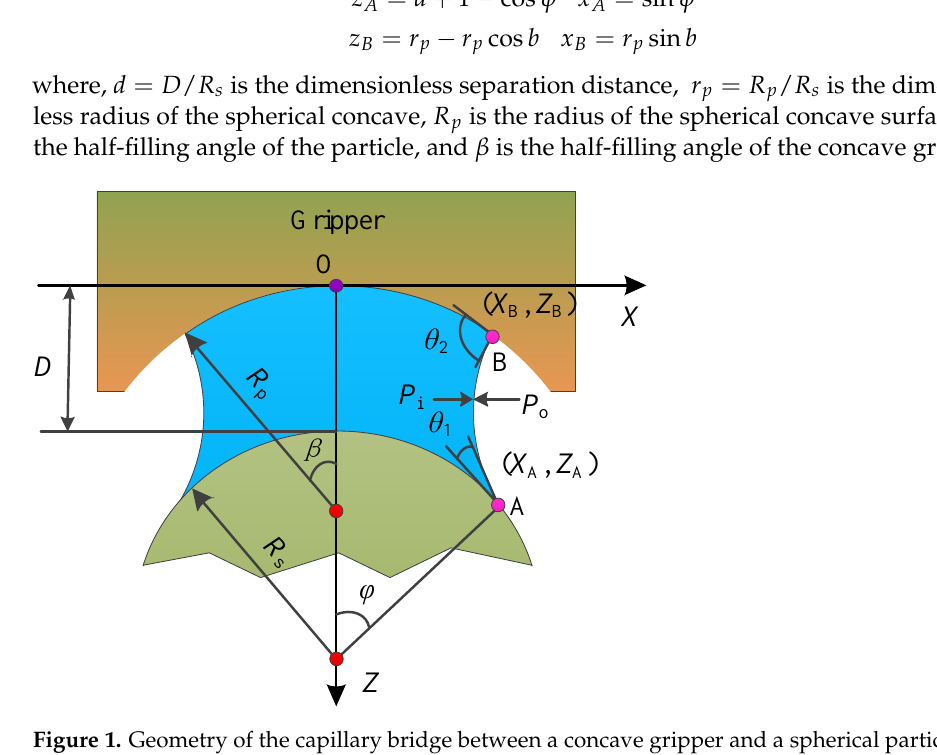
Figure 1. Geometry of the capillary bridge between a concave gripper and a spherical particle.